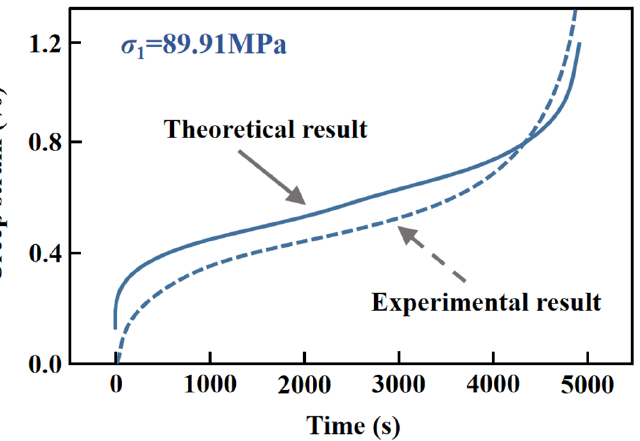
Figure 5. Comparison between the theoretical and experimental results of Sanxia granite [41].